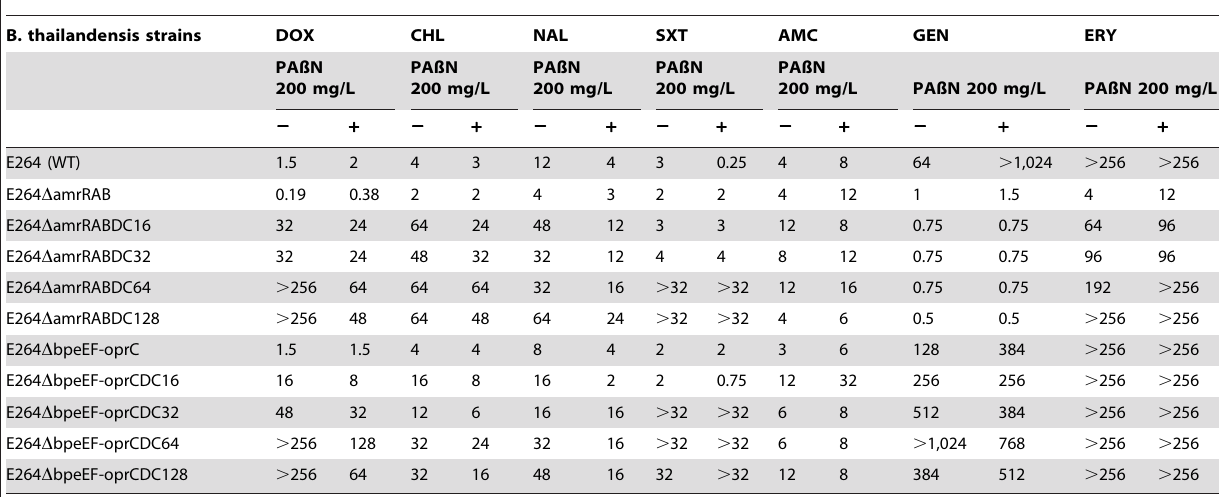
Table 5. Effects of PAßN on the antibiotic susceptibility of B. thailandensis strains and mutants.